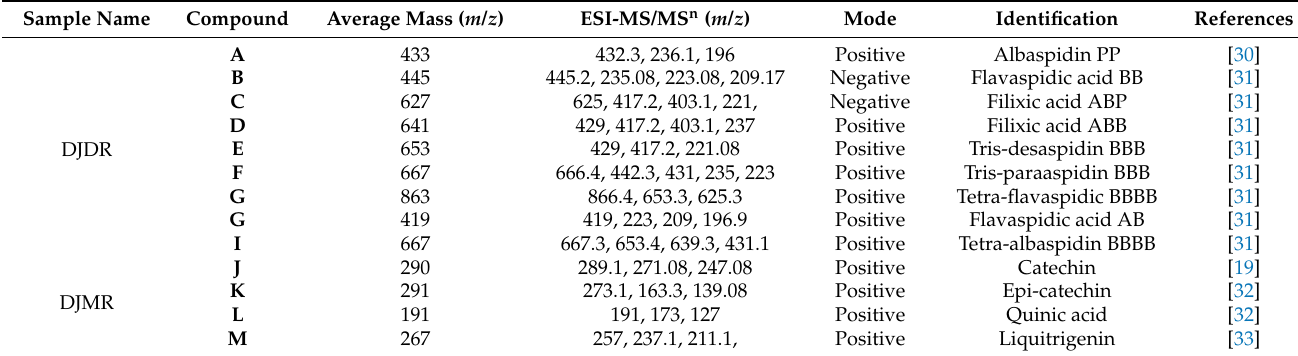
Table 7. ESI-MS/MS analysis of various crude